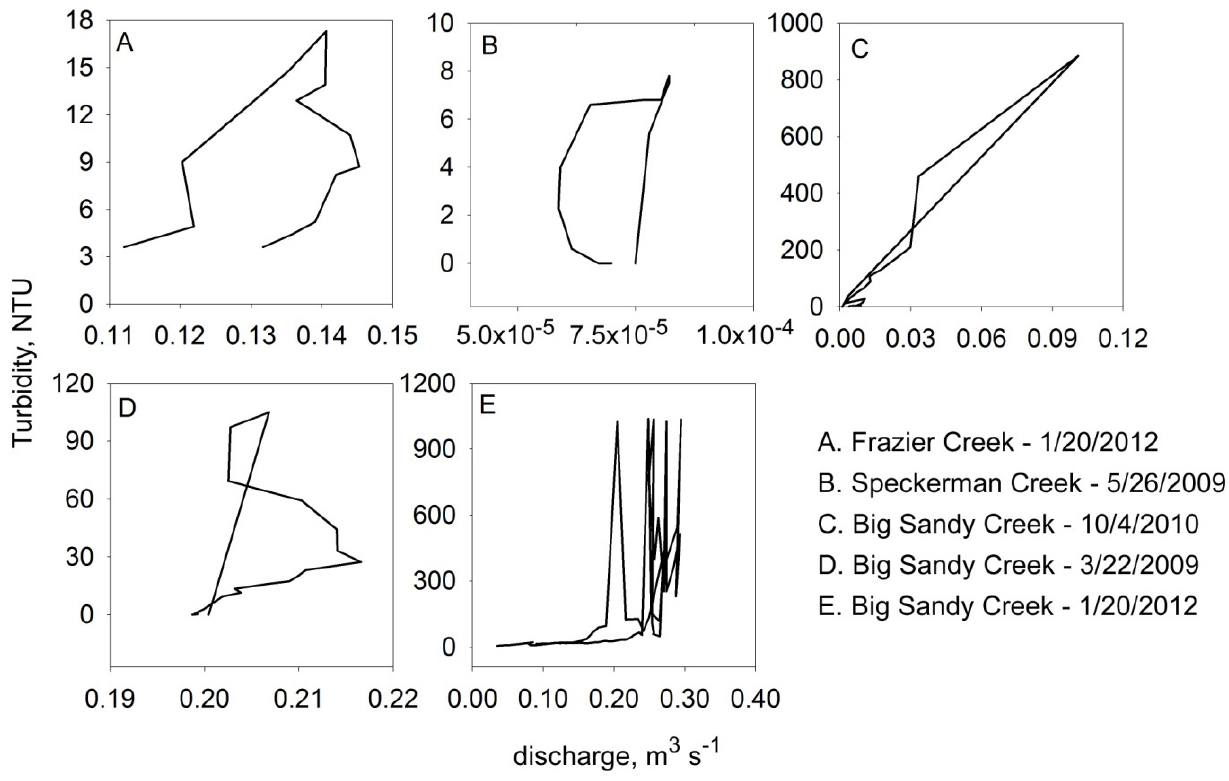
Figure 4. Examples of each of the five hysteresis loop shapes seen in the study area ( A ) clockwise; ( B ) counter clockwise; ( C ) linear; ( D ) figure eight; and ( E )